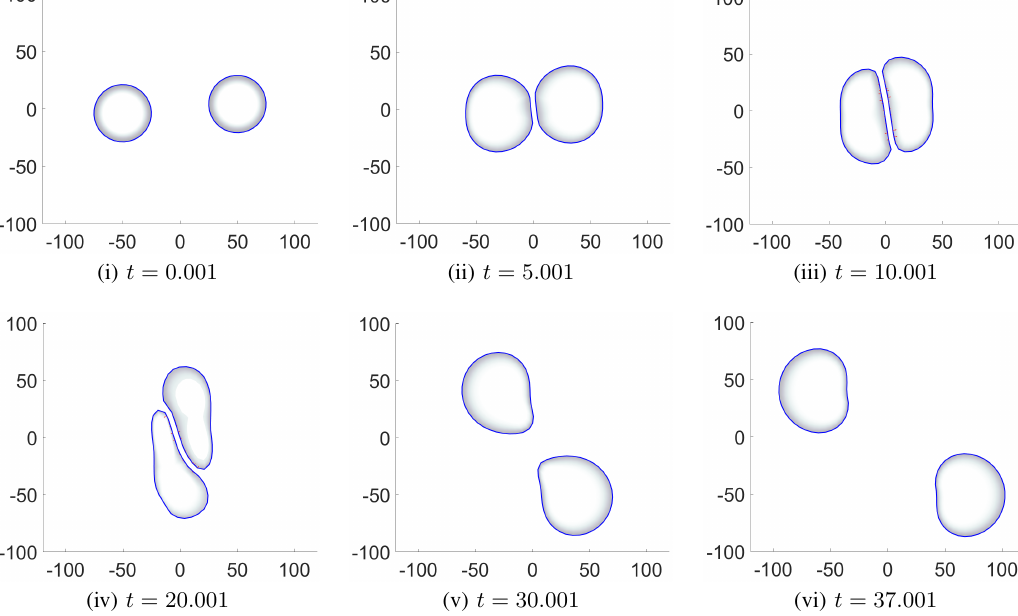
Fig. 4. Experiment 1 (Cell-cell collision). (i): Two FBLM cells migrate in opposing east-west directions. (ii)-(iv): The cells collide and deform due to the exchange of repulsive collision forces. The cells slip by each other. (v)-(vi): The deformation of the cells is elastic and the cells recover their pre-collision morphology.